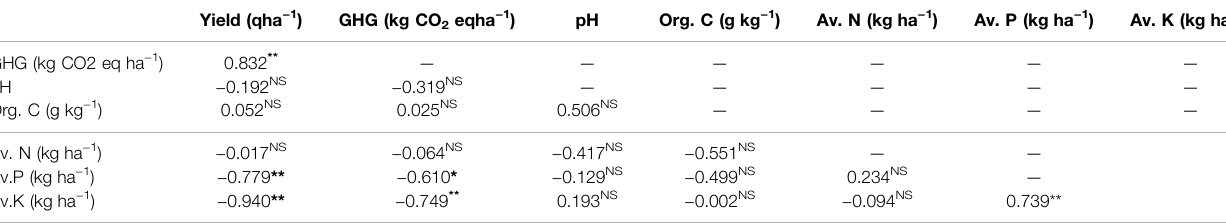
TABLE 4 | Correlation among yield, total GHG emission, and various soil properties (maize).